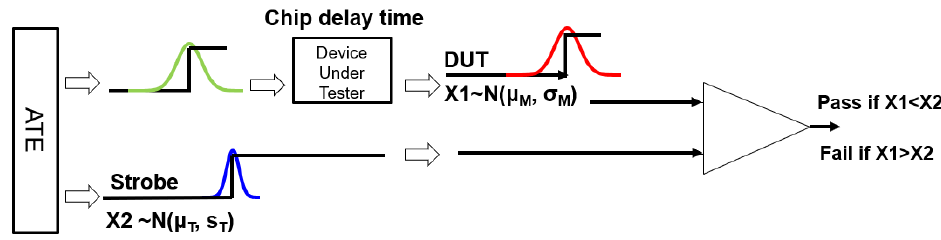
Figure 4. Threshold testing to determine whether the product is “pass” or “fail”.